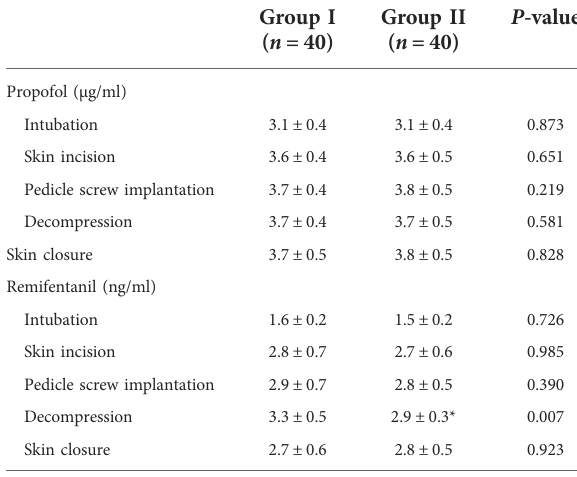
TABLE 1 Demographic and operative characteristics of the study patients.